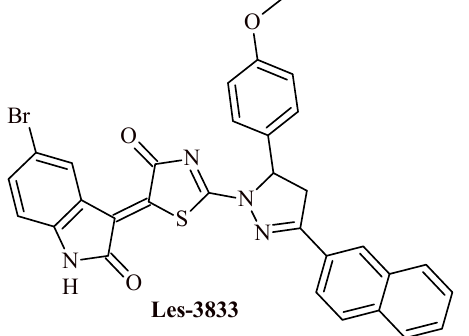
Figure 20. The structures of thiazolidin-4-one-based derivative Les-3833. The studies conducted by Shawky et al. concern to anticancer activity of pyrrolizine- thiazolidin-4-one derivatives ( 48a – 48c and 49 ) (Figure 21) [54]. The cytotoxicity was eval- uated by the MTT assay. The results displayed potential cytotoxic activity with IC 50 values in the range of 0.11–4.24 µM, toward three cancer cell lines (MCF-7, A2780 and HT-29). Among the pyrrolizine-thiazolidin-4-one hybrids ( 48a – 48c and 49 ), Compound 48a showed highest anticancer potential against breast cancer cell line (MCF-7) with IC 50 = 0.16 ± 0.08 µM. While Compound 48b was the most active against A2780 (IC 50 = 0.11 ± 0.01 µM) and HT-29 (IC 50 = 0.12 ± 0.03 µM). The Compounds 48a – 48c and 49 were also evaluated for their selectivity toward normal MRC5 cells. Generally, pyrrolizine-thiazolidin-4-one derivatives exhibited selectivity index (SI) in the range of 3–15 against MCF-7 and A2780 cell lines. The Compound 49 showed the highest selectivity against all three cell lines (SI = 2.62 for A2780 cells, SI = 5.39 for HT-29 and SI = 13.21 for MCF-7cells).